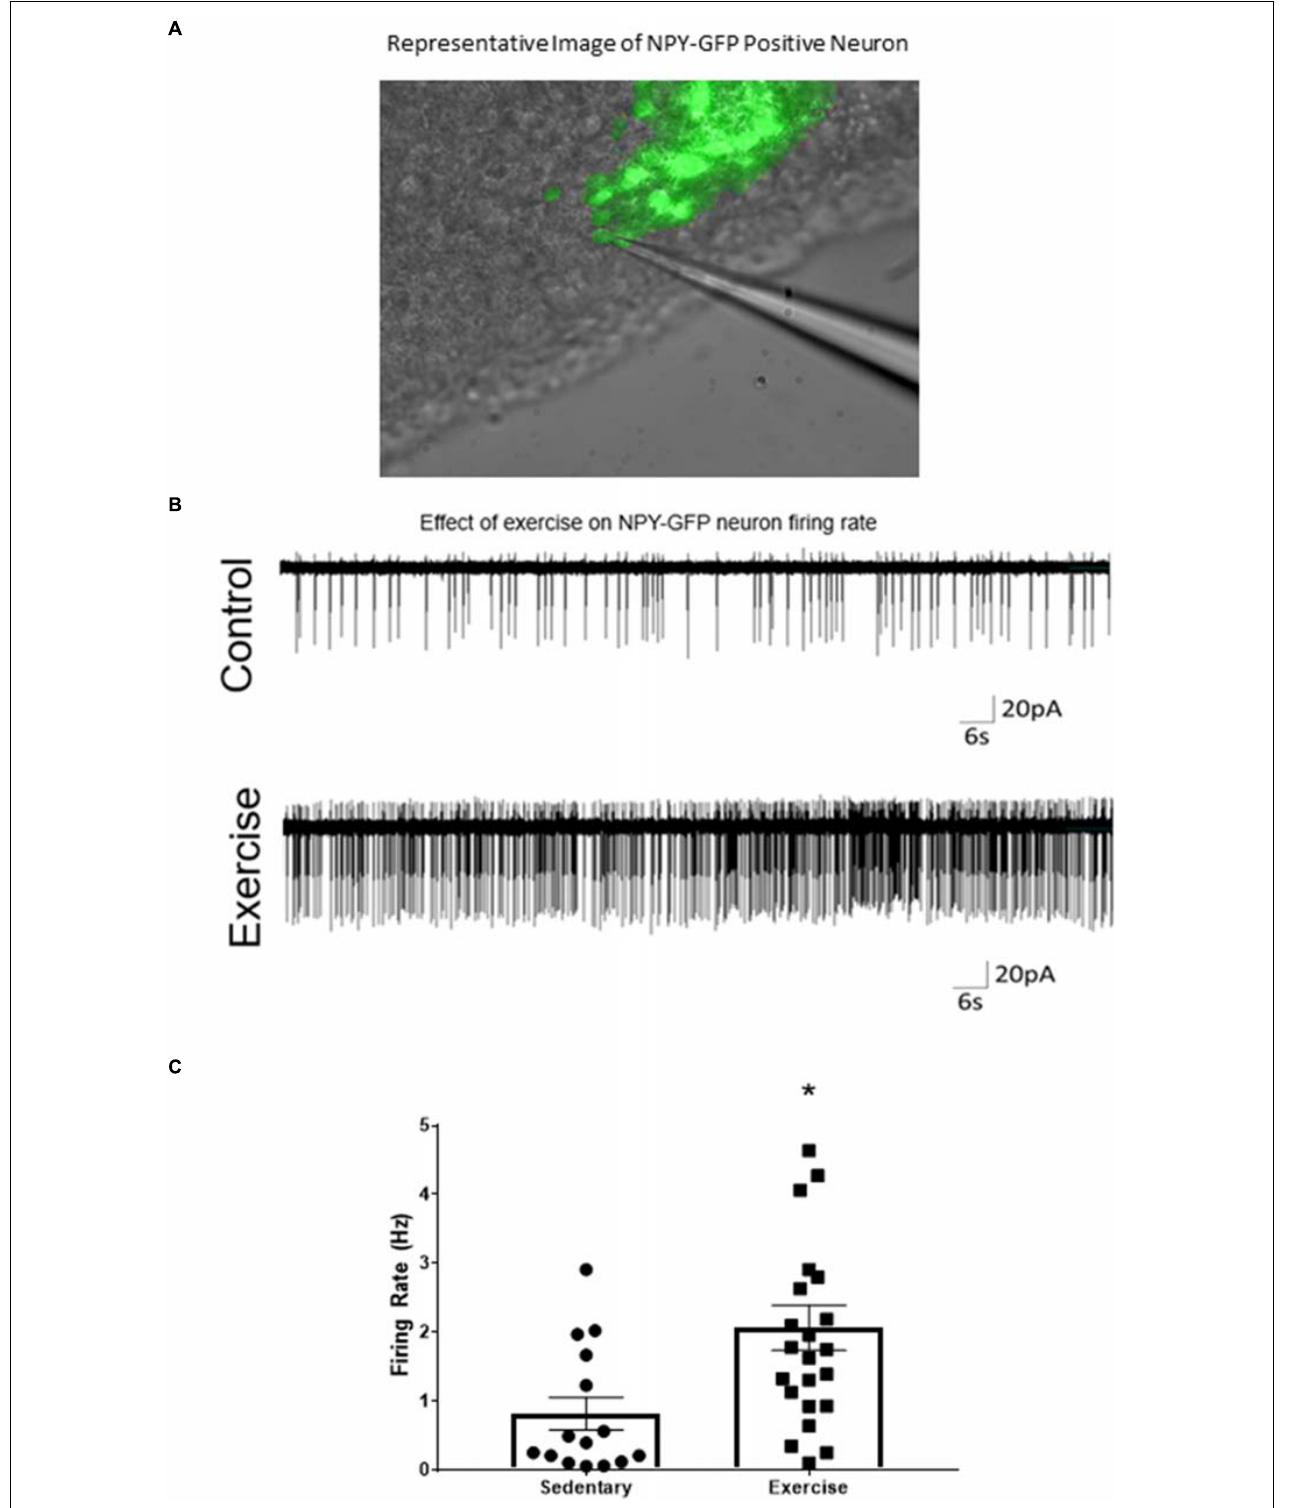
FIGURE 2 | ARC AgRP / NPY neuron firing rate ex vivo is increased after an acute bout of exercise. (A) Representative image of patch-clamp pipette sealed to NPY-GFP neuron in the ARC. (B) Representative cell attached trace of ARC AgRP / NPY neuron firing rate in voltage clamp (–50 mV) after sedentary and exercise conditions. (C) Calculated firing rate of ARC AgRP / NPY neurons in mice. Data are expressed as mean ± SEM. ( N = 15–22 neurons from 8 mice (4 male and 4 female) per group) * indicates p < 0.05 vs. sedentary group.